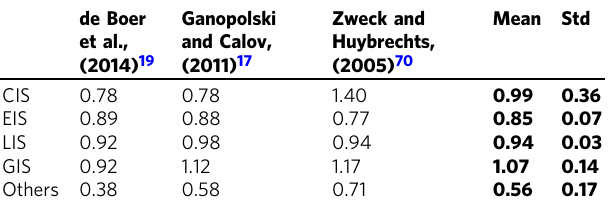
Table 1 Area-volume scaling coef fi cients, c , for the different NH ice sheets as calculated from the output of three numerical ice-sheet modelling